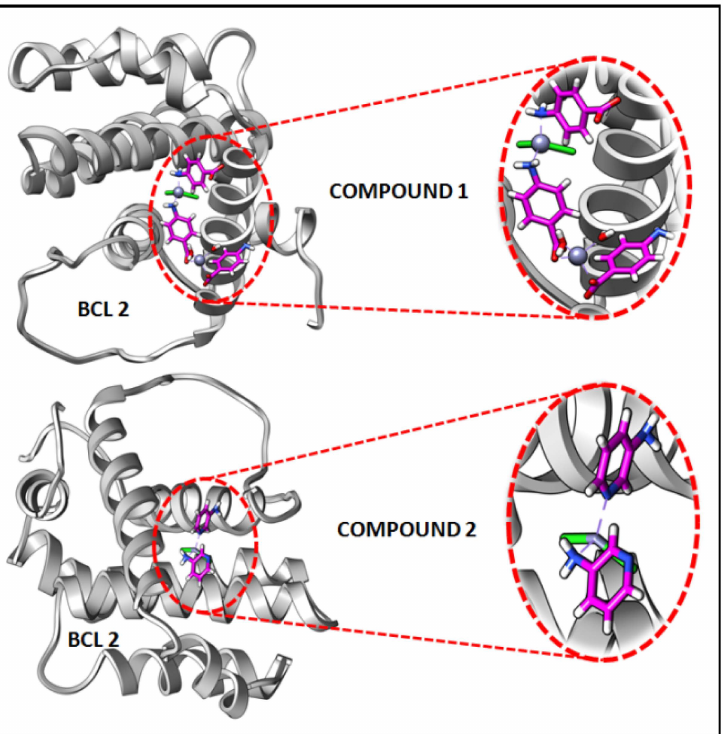
Figure 15. Docking results of modelled fragments of the compounds 1 and 2 with BCL-2 receptor.